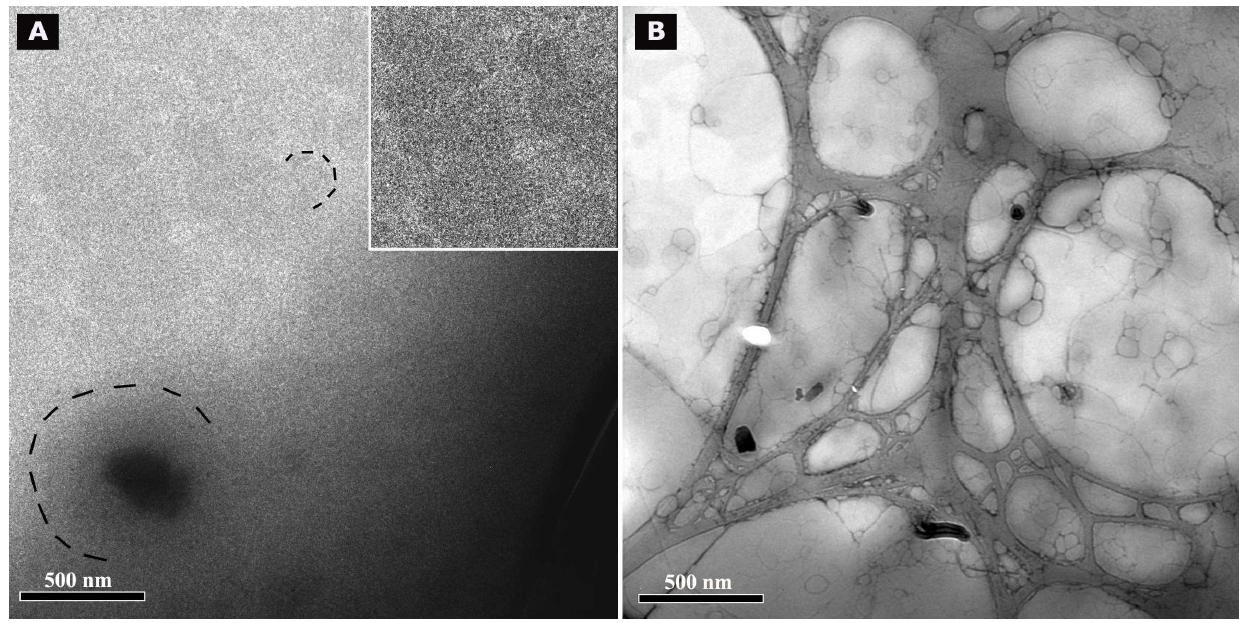
Figure 5. Analysis of the microstructure of blank macroemulsions by cryo TEM (5A) and conventional TEM after negative staining with uranyl acetate (5B) . The magnification is illustrated by the black scale